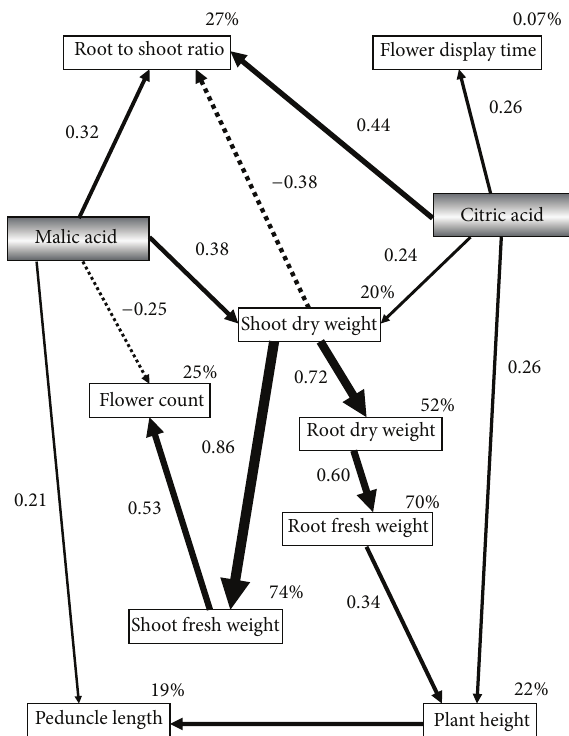
Figure 1: The path analysis of experimental data. Dashed lines indicate negative coefficients, and the width of the arrow indicates the strength of the effect. The lines represent significant effect and the numbers on arrows are standardized regression coefficients (when factor goes up or down by 1 standard deviation, the variable goes up or down by the multiplying the mentioned number in its standard deviation). The numbers on the upper corner of each variable are determination coefficient (R 2 ) (e.g., it is estimated that the predictors of the root dry weight explain 52 percent of its variance). Variation due to error is not included for